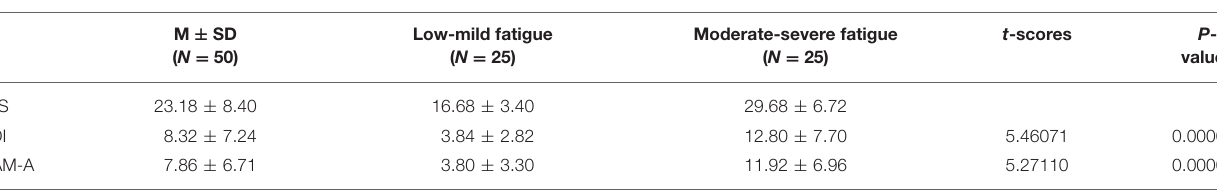
TABLE 5 | Follow-up: psychological assessment